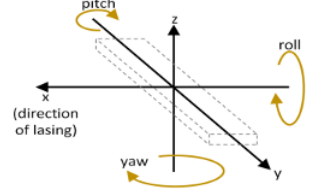
Fig. 2. Degrees of freedom and